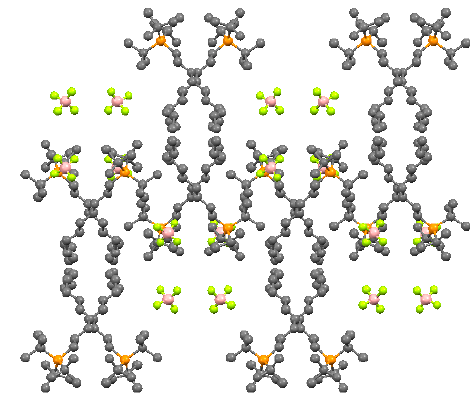
Figure 3. Crystal packing of 5b .